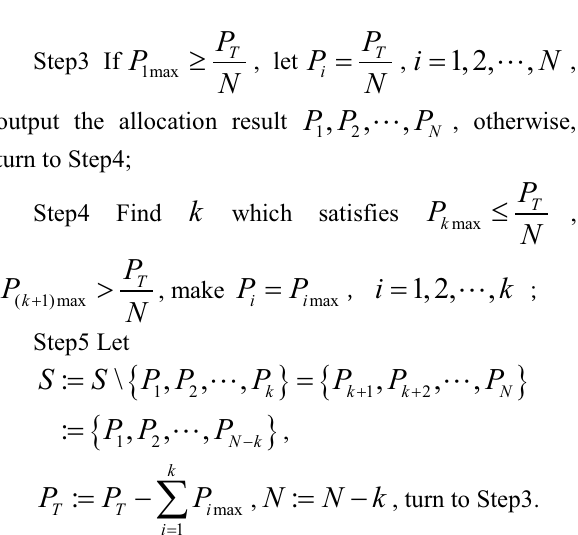
Flow chart of the algorithm is shown in figure 2.